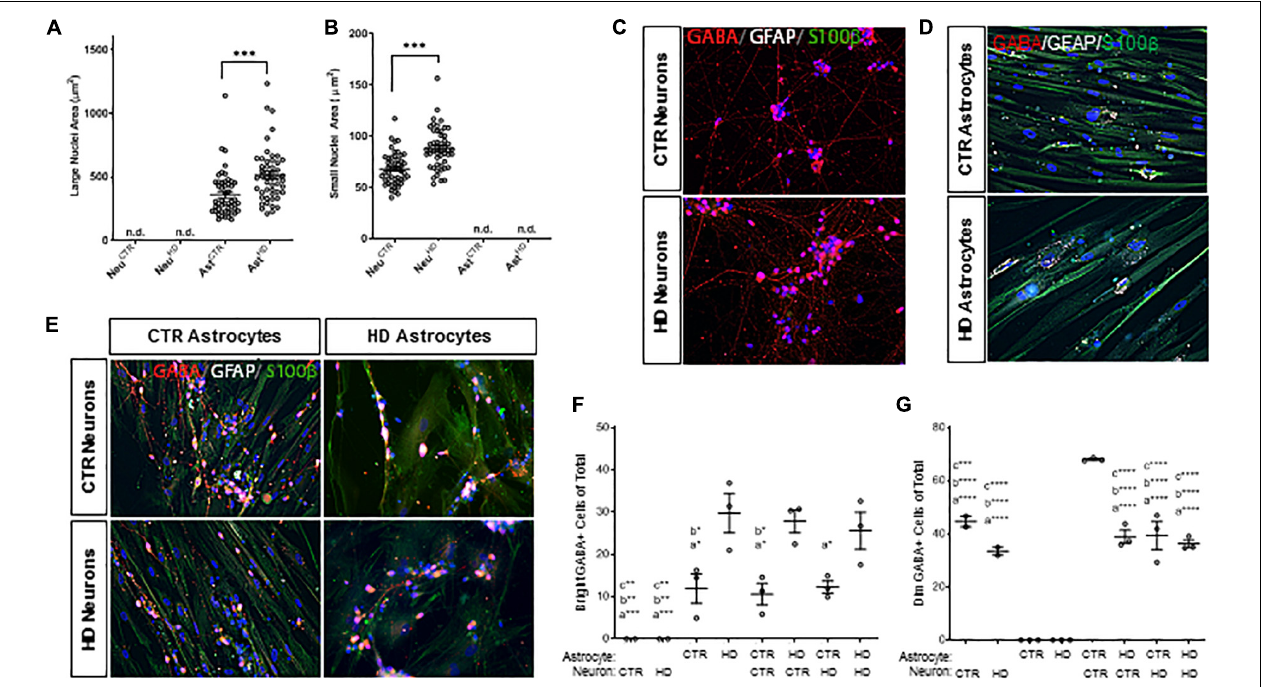
FIGURE 5 | Stage 4 HD (HD109) and control (CTR33) astrocytes (large nuclei, > 210 µ m 2 ) and neurons (small nuclei, < 141 µ m 2 ) in mono- or co-culture display differences in both nuclear size and percent of cells expressing GABA. (A) HD astrocyte nuclei are larger than control astrocytes. No large nuclei are detected in the neuronal cultures. (B) HD neuronal nuclei are larger than control neuronal nuclei. No small nuclei are detected in the Stage 4 astrocyte cultures. (C–E) GABA (red), GFAP (white) and S100 β (green) expression in panel (C) control and HD neurons, (D) control and HD astrocytes, (E) co-culture matrix of HD and control astrocytes/neurons. (F) HD astrocytes in mono-culture or co-culture have a higher percentage of cells expressing a dim, punctate GABA compared to control astrocytes. Significance between conditions denoted as “a”: from Ast HD , “b”: from Neu CTR + Ast HD , “c”: from Ast HD + Neu HD . (G) Control neurons in mono-culture have a higher percentage of cells expressing a bright cytoplasmic GABA stain than HD neurons in mono-culture, which is increased upon addition of control astrocyte co-culture. Significance between conditions denoted as “a”: from Ast CTR , “b”: from Ast HD , “c”: from Ast CTR + Neu CTR . These cells were analyzed from more than three separate experiments. Ast, astrocyte; Neu, neuron; CTR, control. One-way ANOVA ( ∗ p < 0.05, ∗∗ p < 0.01, ∗∗∗ p < 0.001, and ∗∗∗∗ p <